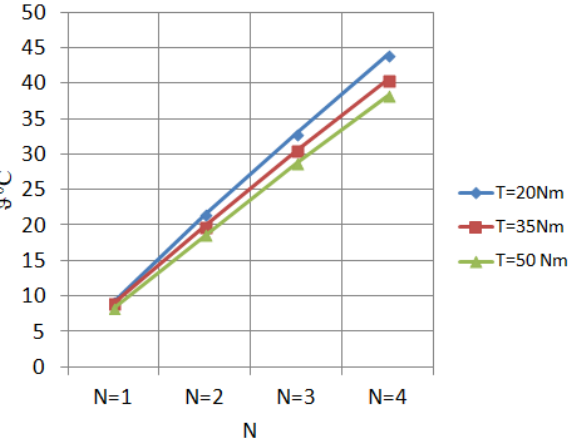
Figure 11. Maximum temperature ϑ max in the working region (the highest possible temperature for MR fluid) vs. the number of discs N for T c = 20, 35 and 50